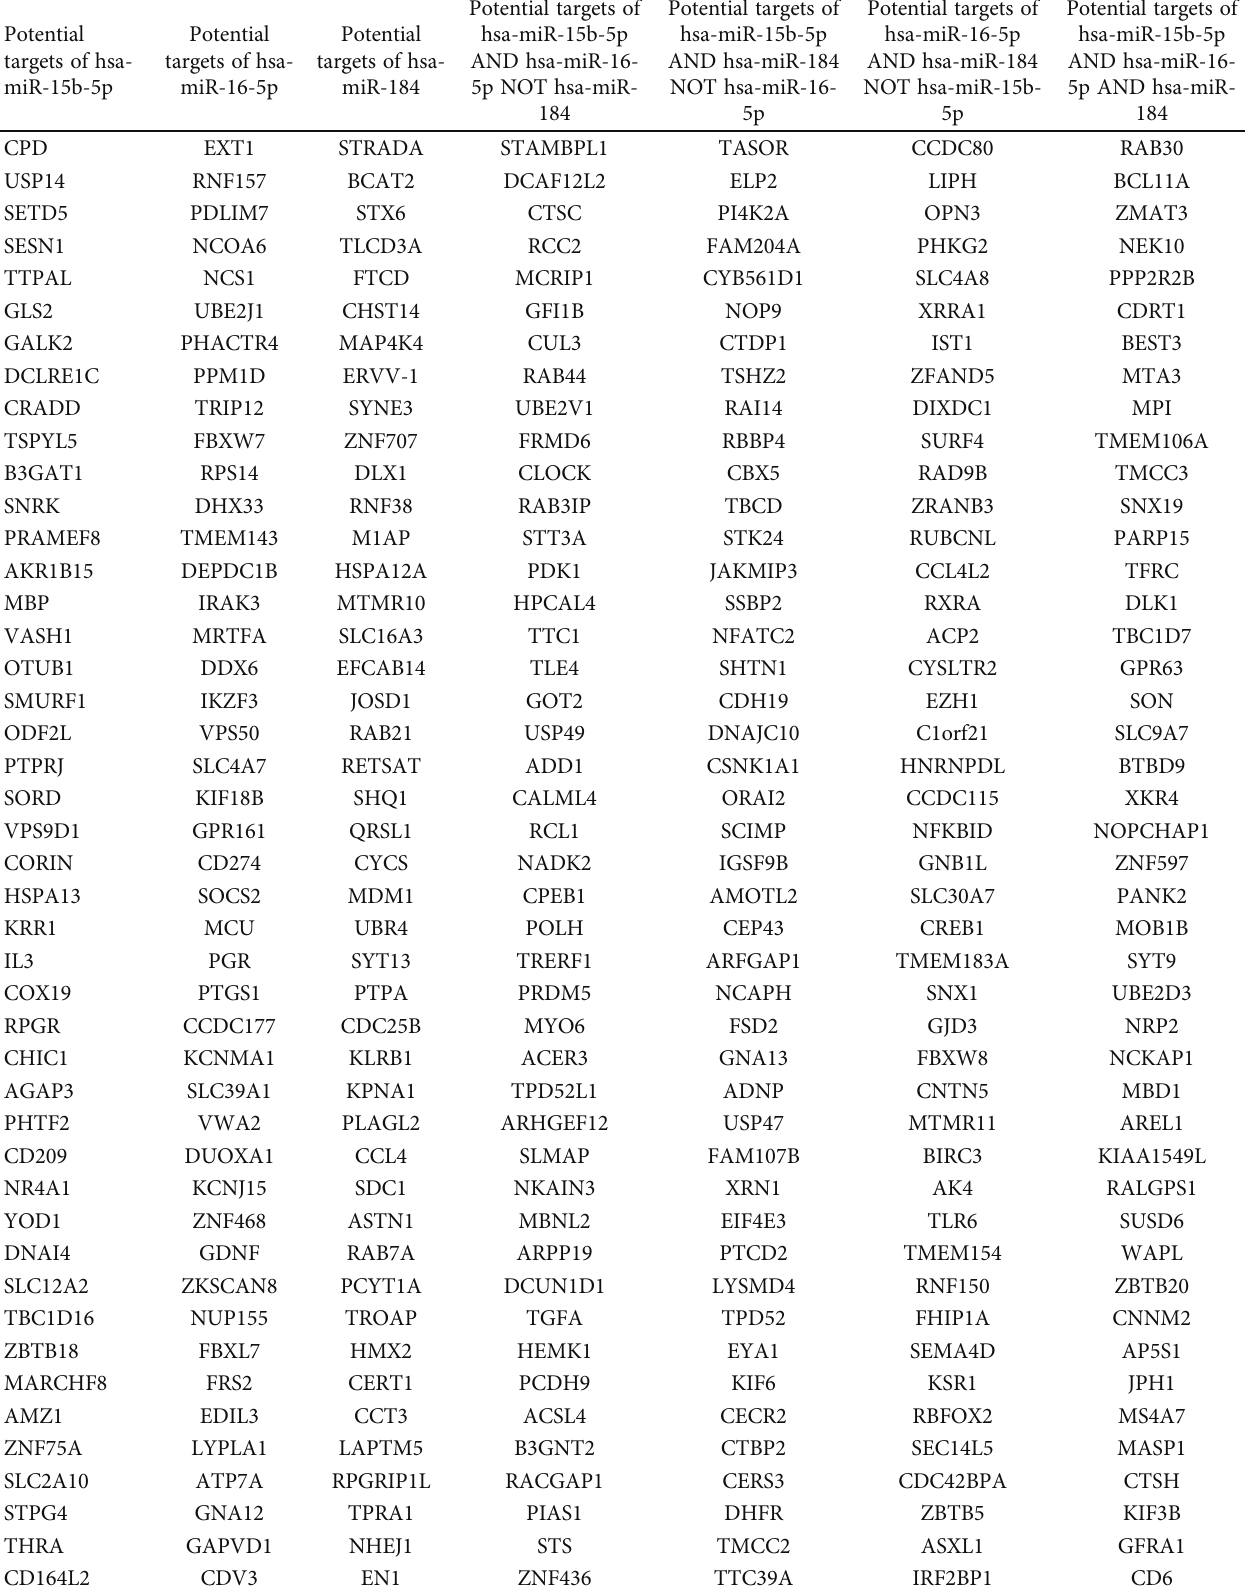
Table 2: Target genes of the three